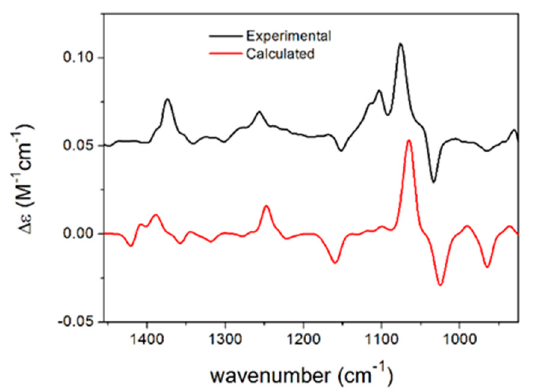
Figure 2. Comparison of the experimental VCD spectrum of F measured in CDCl 3 and the calculated VCD spectrum of cis -(5 S ,6 S )- F computed at the B3LYP/TZVP PCM/CHCl 3 level for the eight lowest-energy conformers gained from the DFT optimization performed at the same level.